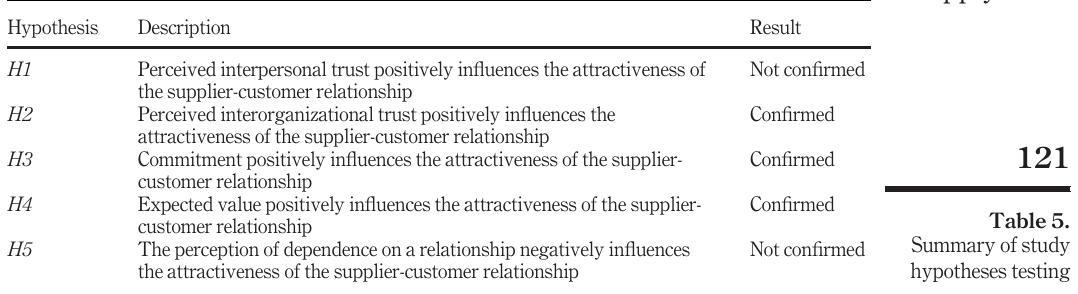
Table 5. Summary of